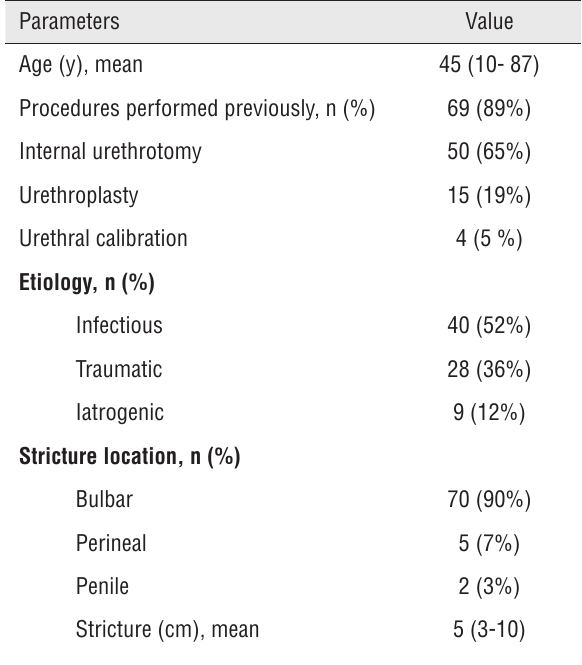
Table 1 - Preoperative parameters.